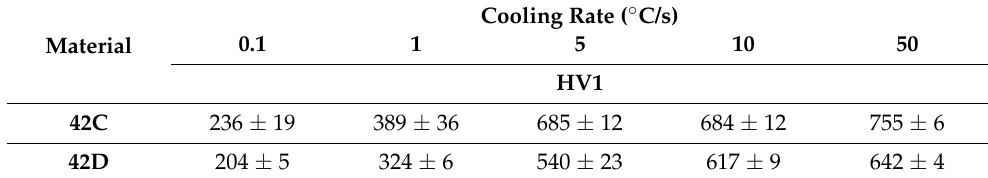
Table 5. Microhardness HV1 measurement for 42C and 42D